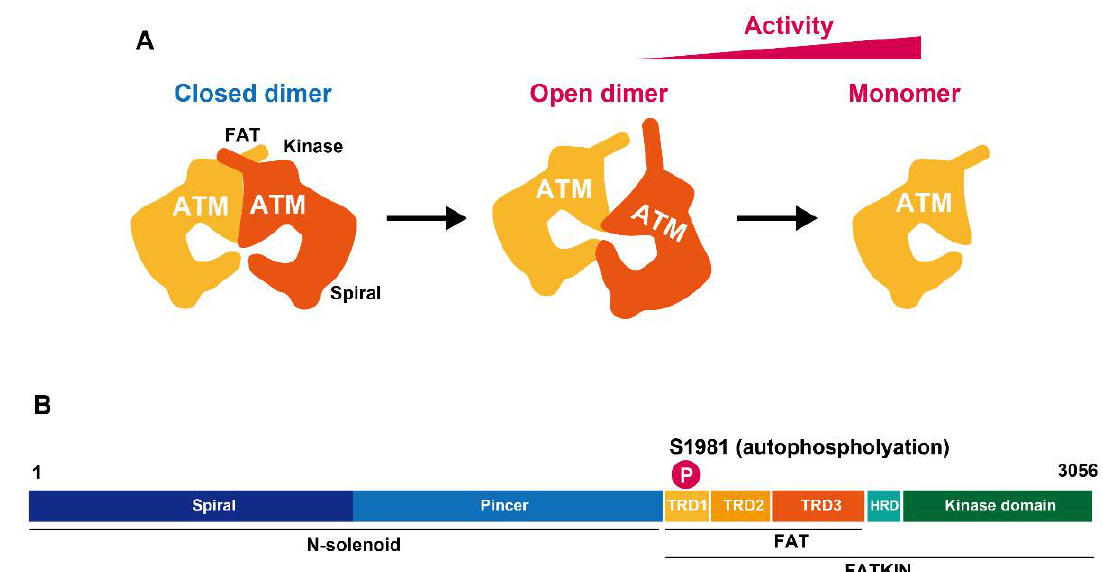
Figure 1. ATM activation after DSB formation. ( A ) ATM structure is associated with the kinase activity. The monomeric form has greater kinase activity than the dimeric form. ( B ) A two-dimensional ATM structure with some of ATM’s relevant domains indicated.